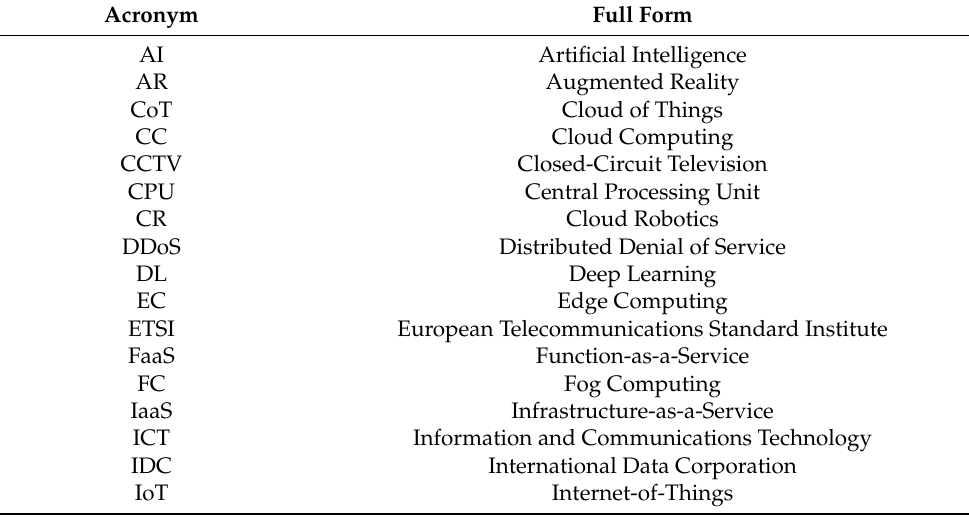
Table 1. List of acronyms used in the manuscript and their